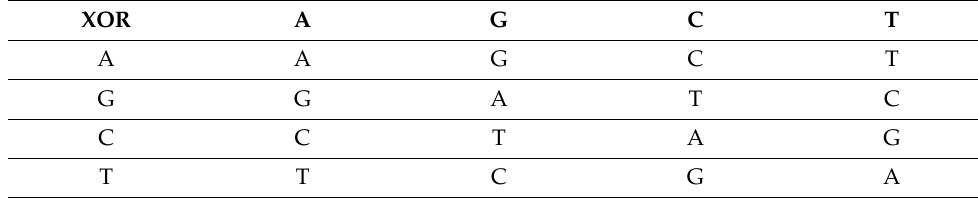
Table 2. DNA XOR operation rules.